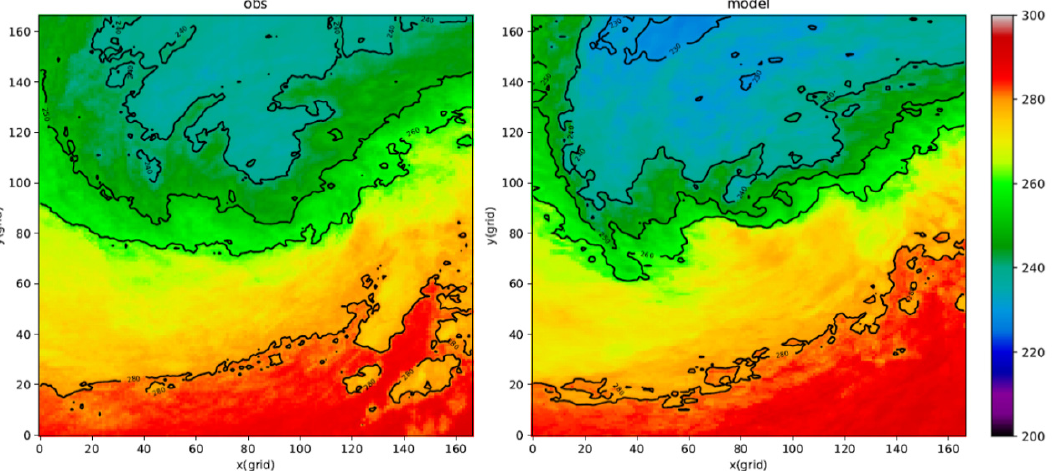
Figure 9. Hurricane Dorian observed and model synthetic GOES-R IR BT in the storm’s decay